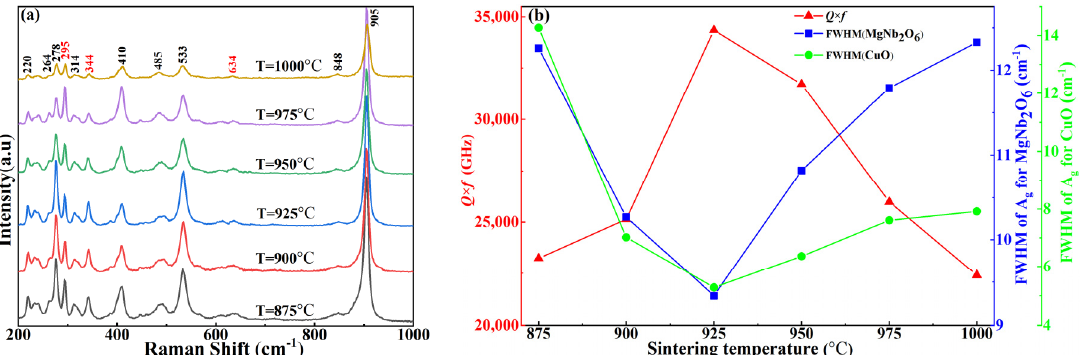
Figure 4. ( a ) The Raman spectra of MgCu 2 Nb 2 O 8 ceramics; ( b ) The correlations between Q × f val- ues and FWHM values.